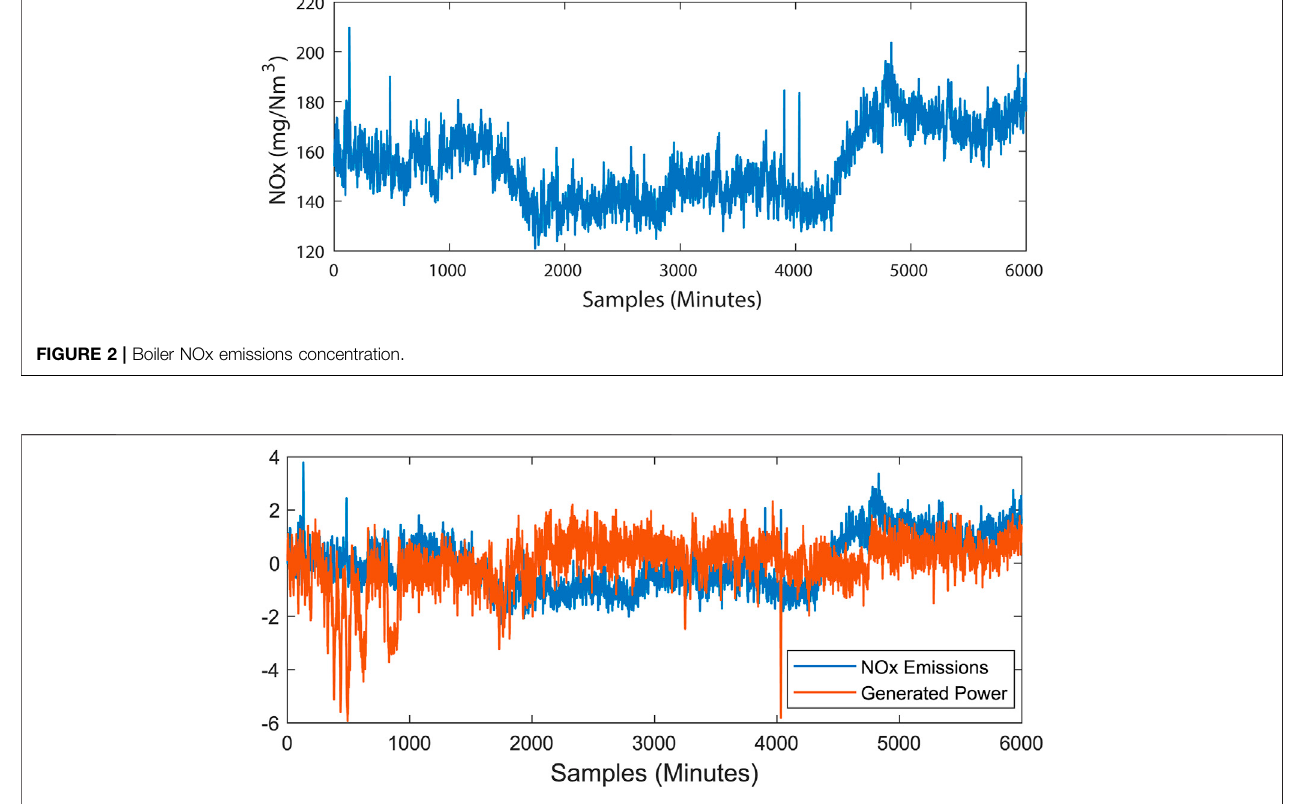
FIGURE 3 | Variation in unit load with NOx